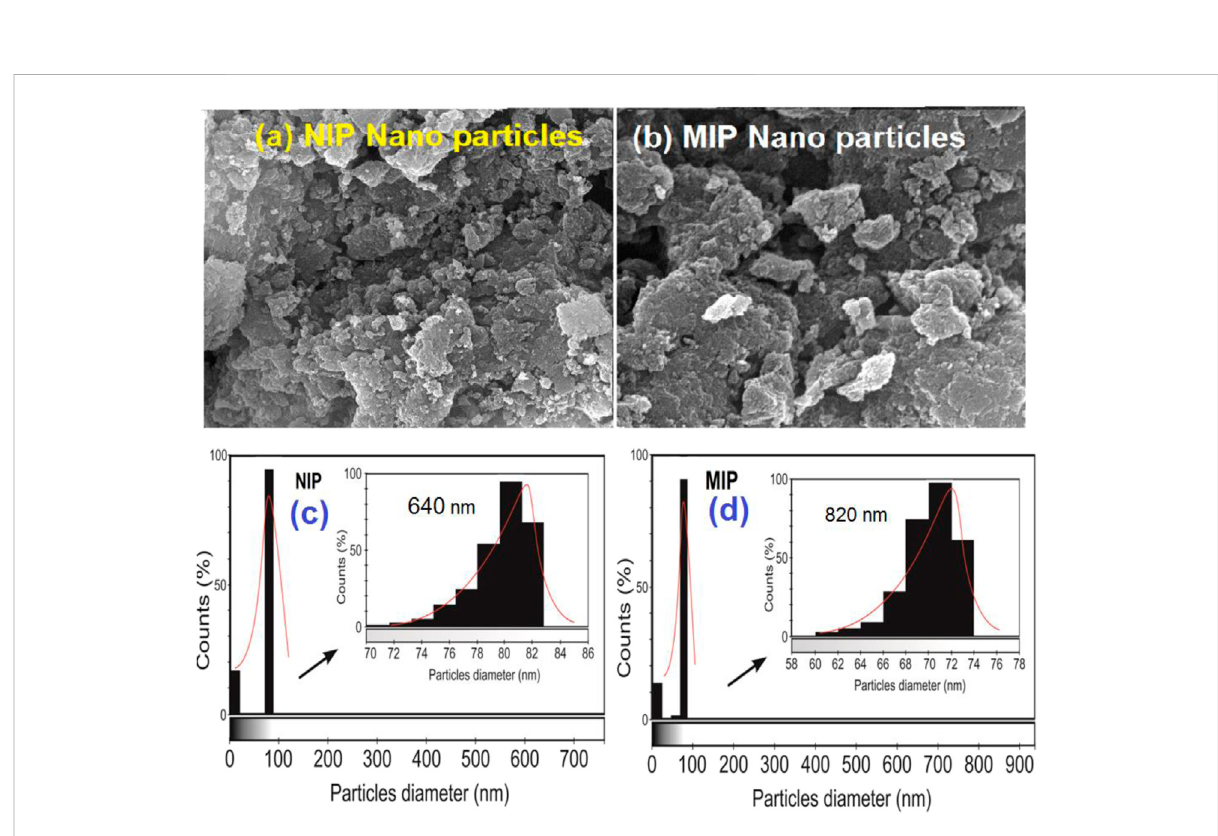
FIGURE 3 SEMimagesof (A) NIPnanoparticles, (B) MIPnanoparticles,andtheparticlediametercountdiagramspreparedbyImageJ1.53ksoftwarefor (C) NIP and (D)